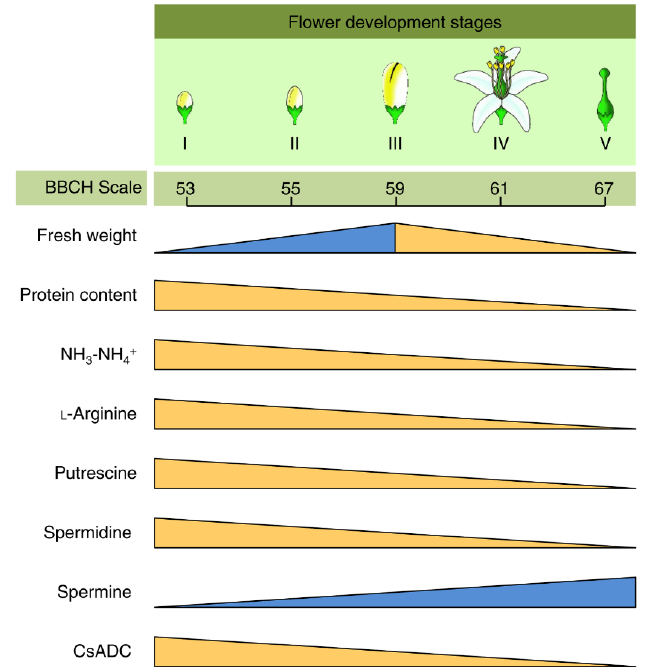
Figure 5. Schematic overview representation of the metabolic behavior of polyamines (PAs), some other nitrogen-containing metabolites, and the major PAs-biosynthetic gene, Arginine decarboxylase ( ADC ), during the floral development of citrus plants. Flower development stages (53, 55, 59, 61, and 67) are corresponding to the phenological growth stages on BBCH-scale [149,150]. Yellow bars/triangles represent the reduction in the metabolite levels or down-regulation in gene expression, while blue bars/triangles represent the increase in the metabolite levels or up-regulation in gene expression. For more details, see the main text.